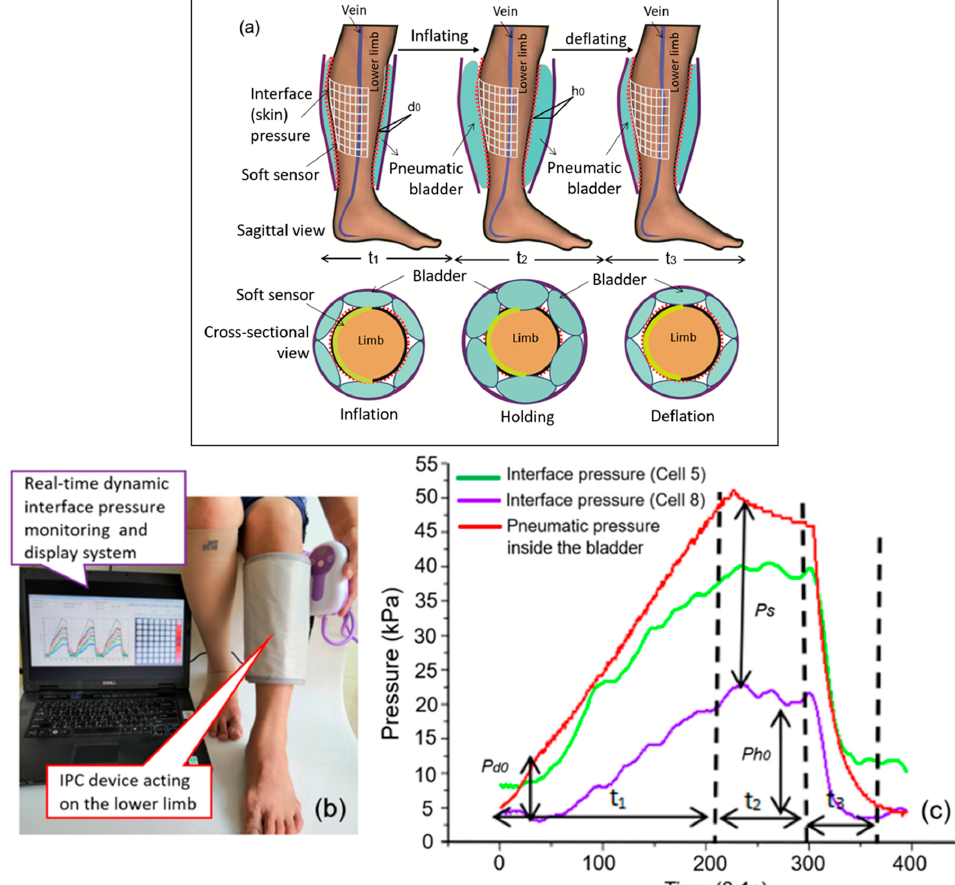
Figure 11. ( a ) The sagittal and transverse views of the bladder and the lower limb system in deflation- holding and deflation cycle; ( b ) Dynamic pressure monitoring system under IPC-lower limb action in practice. ( c ) Variation curves of the integrated interface pressures and pneumatic pressures detected by the developed IPC dynamic pressure monitoring system in one compression